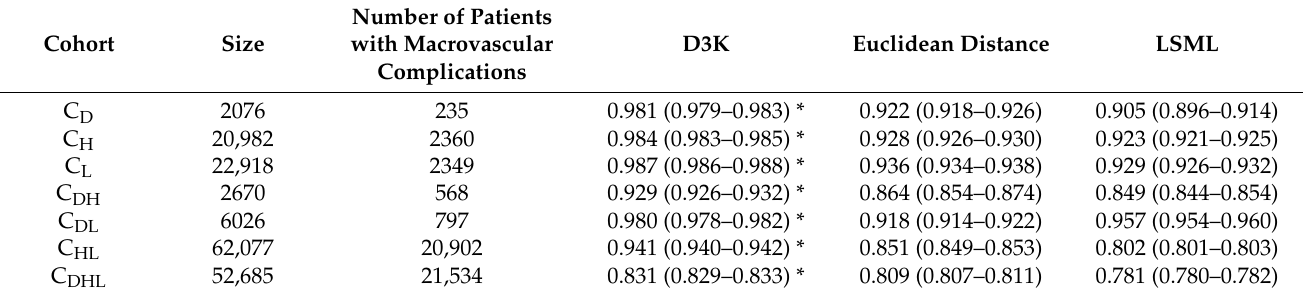
Table 8. Results of nDCG@10 for the different cohorts in the format “mean (95% confidence interval)”.